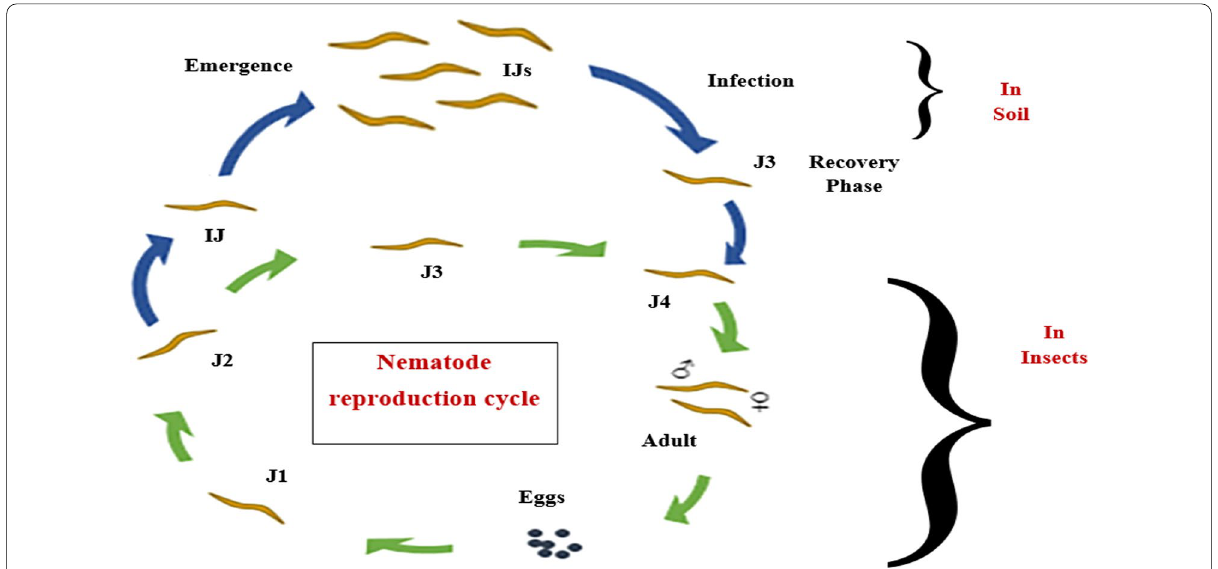
Fig. 3 Reproduction cycle of entomopathogenic nematodes (in soil—free living stages; in insects—parasitic